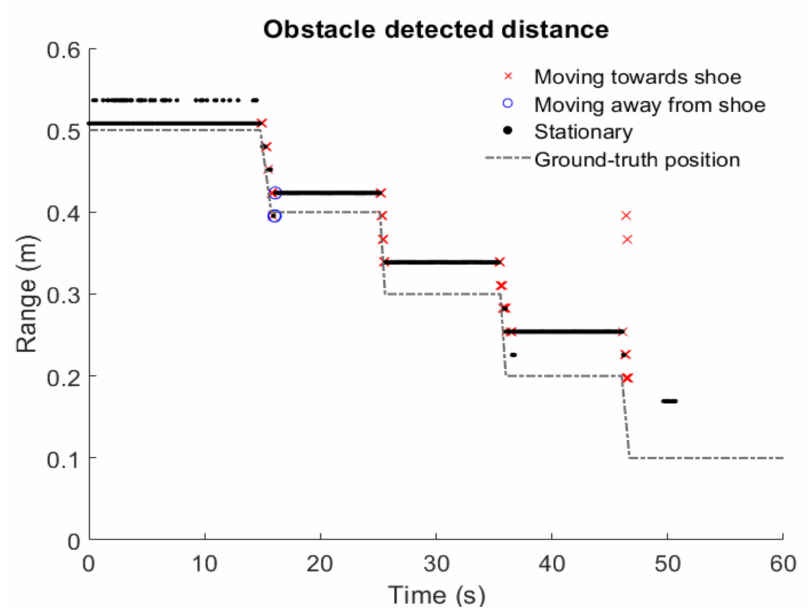
Figure 9. Experimental results. The radar was able to detect the obstacle at a distance between 10 cm and 70 cm. The accuracy improves as the obstacle is moved away from the radar. This effect could be caused by the near-field effects, where the incident reflections can no longer be considered parallel. A possible solution is to repeat this experiment several times to obtain a correction factor to affect the measurements, since the error seems to follow a linear